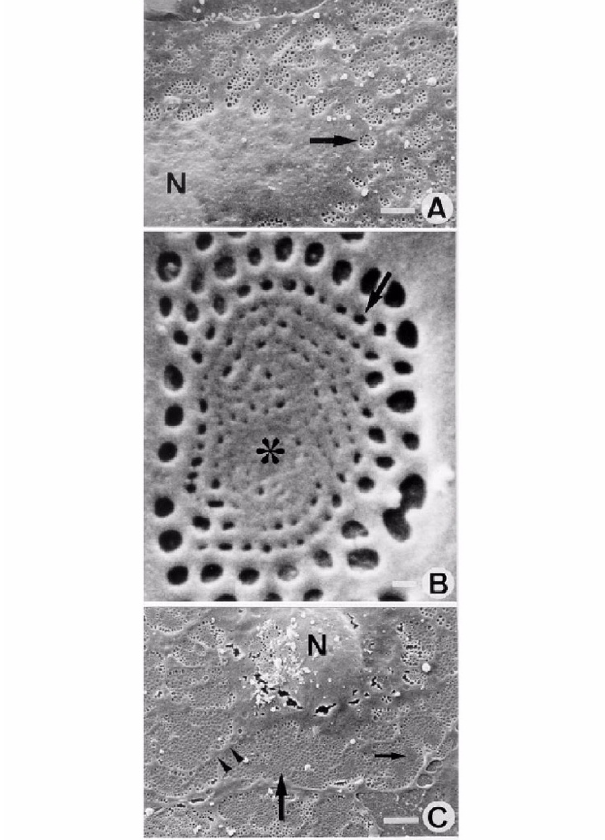
Figure 2 Scanning electron microscopic (SEM) observations showing the surface topology of control-, and di-h- HALI-treated LSEC. ( A ) SEM micrograph of a control LSEC shows the presence of numerous fenestrae grouped in sieve plates (arrow). The bulging area contains the nucleus (N). Scale bar, 2 µ m. ( B ) High-power SEM micrograph of the fenestrated cytoplasm obtained after 60 minutes exposure to 100 nM di-h-HALI. Note a typical cytoplasmic unfenestrated area (asterisk), surrounded by circular rows of very small fenestrae (arrow), suggesting nascent fenestrae fanning out into the surrounding fenestrated cytoplasm. Scale bar, 250 nm. ( C ) Shows a SEM micrograph of a LSEC treated with 100 nM di-h-HALI for 120 minutes, revealing a substantially increased number of fenestrae (large arrow). Thin nonfenes- trated cytoplasmic arms (arrowheads) divide the cytoplasm into large sieve plates. In the fenestrated cytoplasm, small cytoplasmic unfenestrated areas devoid of connected fenestrae rows could be observed (small arrow), nucleus (N). Scale bar, 2 µ m.